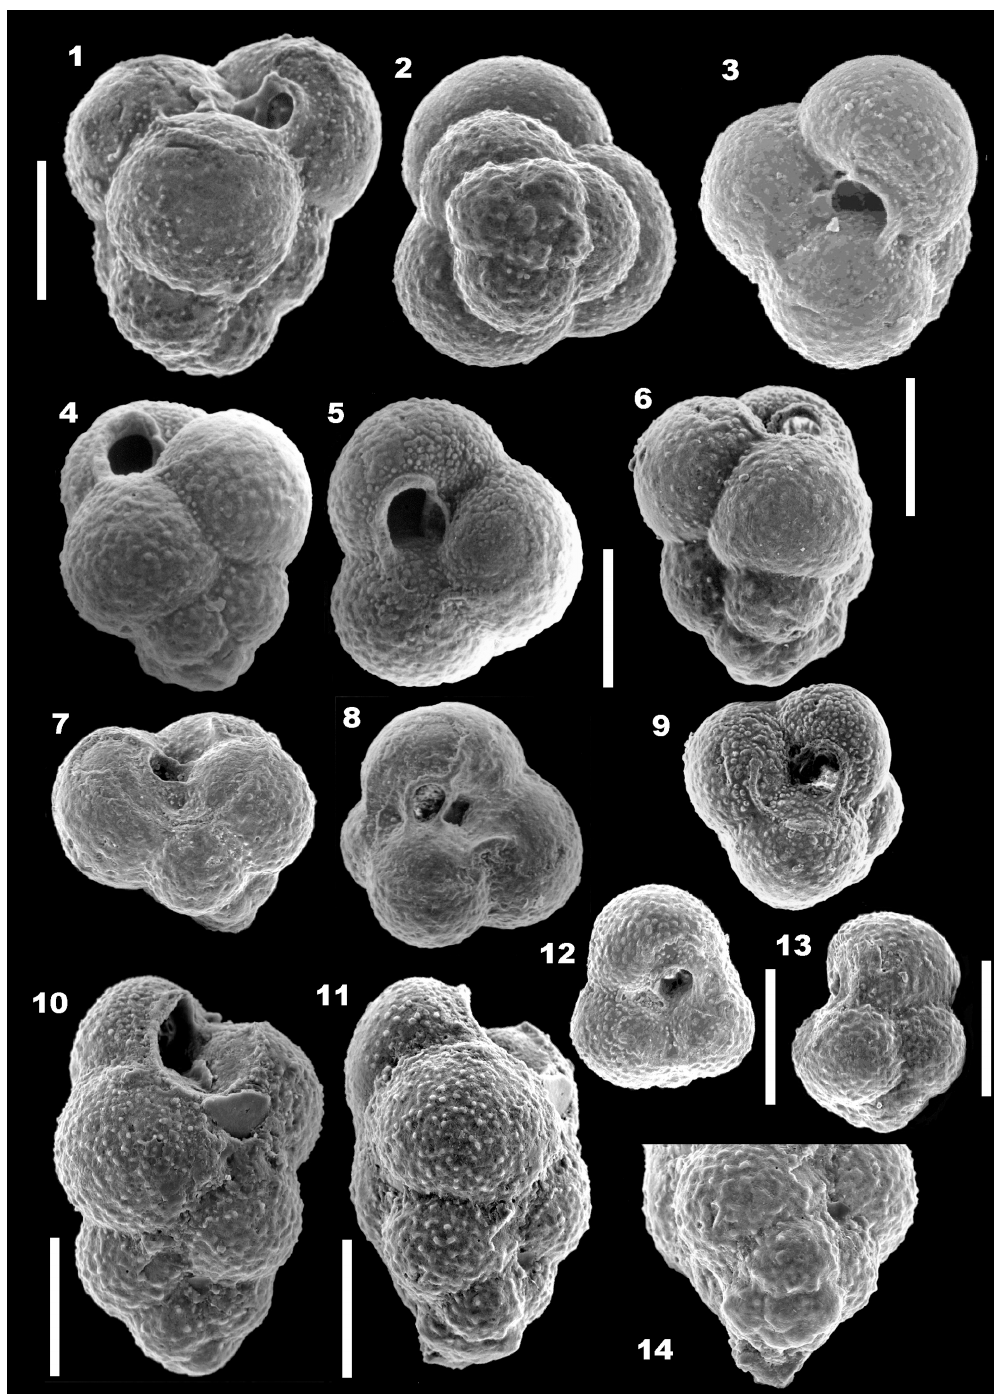
Figure 3. (1–14) Globuligerina bathoniana australiana n. ssp. 1–3 . Paratype WAM 18.11/M2-17. (1) Side view; bulla broken off; (2) spiral (basal) view; (3) slightly oblique umbilical view, with two chambers in earlier whorls visible at right. (4, 5) Paratype WAM 18.12/M64-13; (4) side view; (5) umbilical view. (6, 9) Holotype WAM 18.10/M10-21; (6) side view; (9) oblique umbilical view. Note the scar of a final, centrally positioned bulla. (7, 8) WAM 18.16/M51-04. (7) side view; (8) umbilical view; final chamber broken off. (10, 11, 14) Paratype WAM 18.13/M73-09; (10) side view. The final chamber is broken off, and the apertural face of the second-last chamber is damaged; (11) side view with specimen rotated to show the very low trochospiral coil forming an almost flat base from certain angles. Contrast with the same area as seen in (10) ; (14) specimen at same angle of rotation as in (11) , but tilted away from the viewer to show the initial whorl of four or five chambers, seen in side view in (11) . (12, 13) Specimen WAM 18.15/M51-01; (12) umbilical view; (13) side view. All scale bars are 100µm, and all images on this figure are at the same magnification. All specimens are from sample BMR 95/DR7/8.